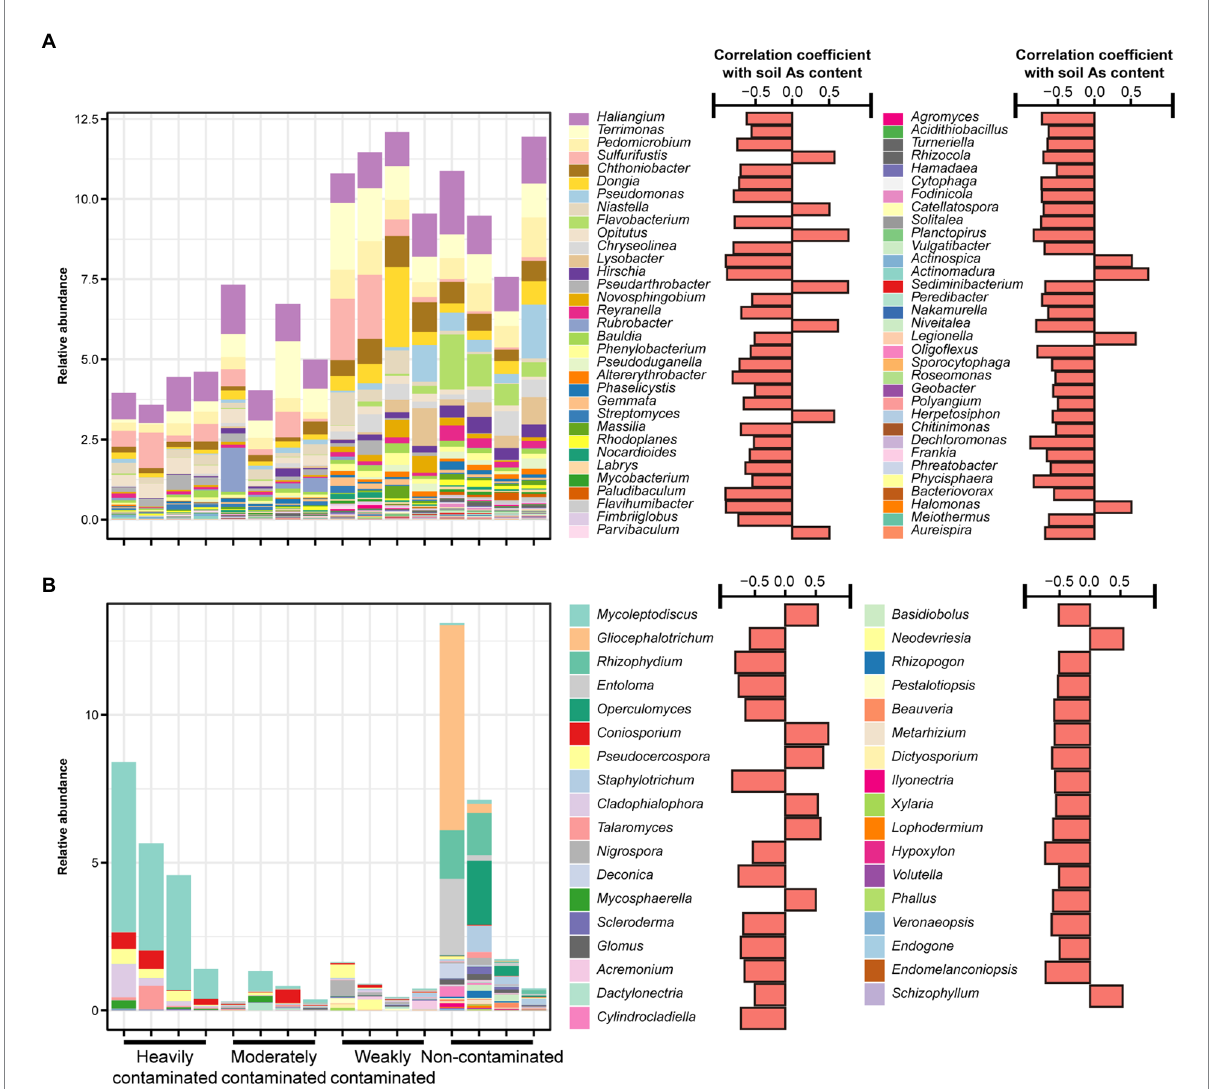
FIGURE 3 Relative abundances of (A) bacterial and (B) fungal genera that significantly correlate with arsenic content in Pteris vittata rhizosphere soil in the field. The bar plots on the right show the correlation coefficients between the relative abundance of these genera and soil arsenic